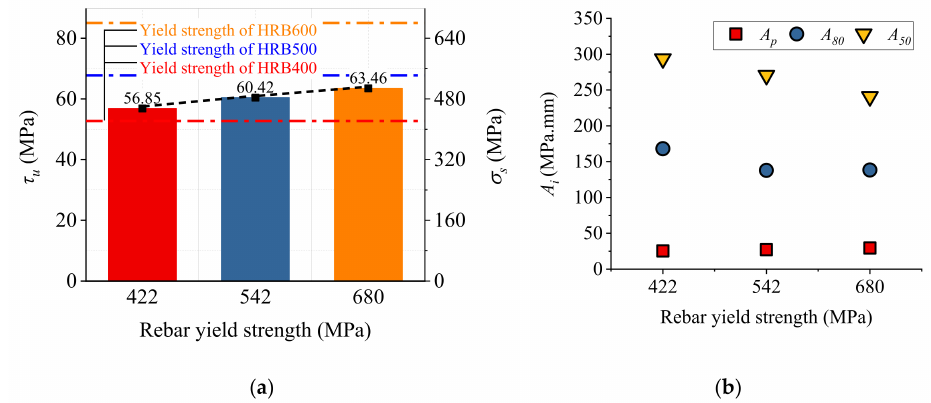
Figure 12. Effect of rebar yield strength on bond performance: ( a ) bond strength; ( b ) bond